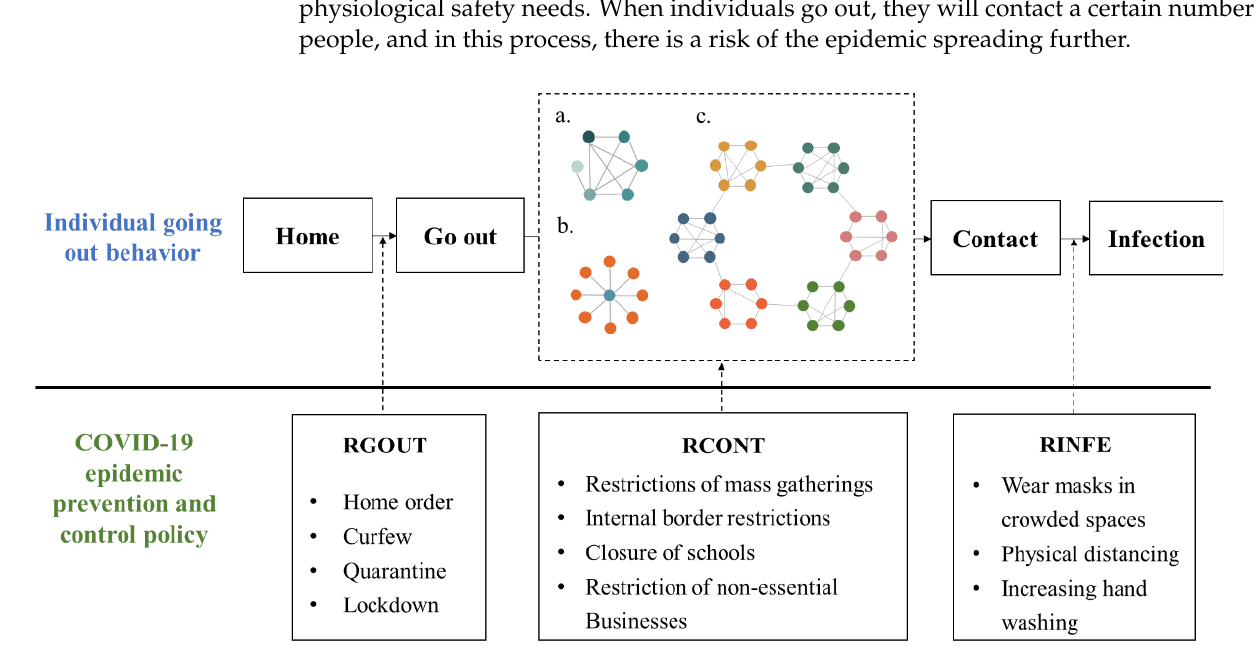
Figure 1. Mechanism diagram based on individual behavior. Note: (a) represents a family network based on family needs; (b) represents a stranger network based on physiological safety needs; (c) represents a friend network based on friendship needs.